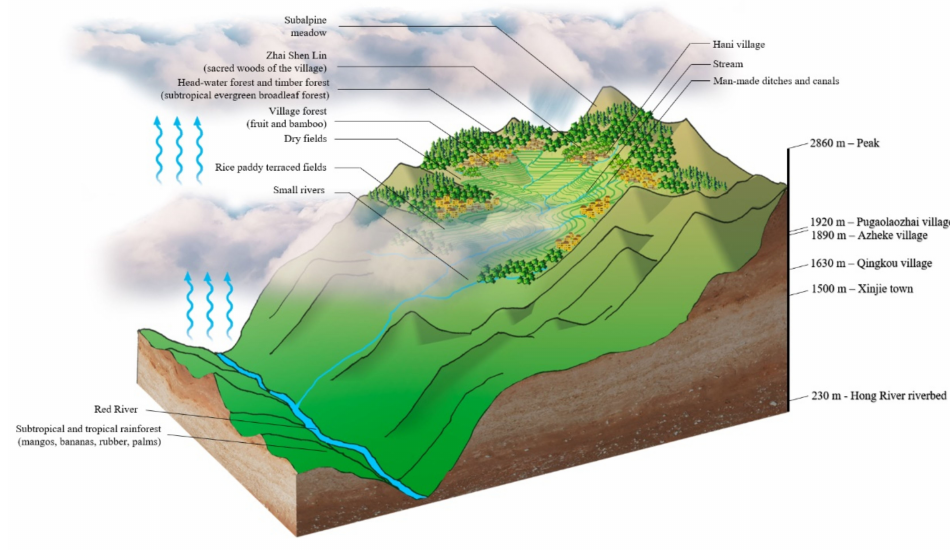
Figure 2. The Hani